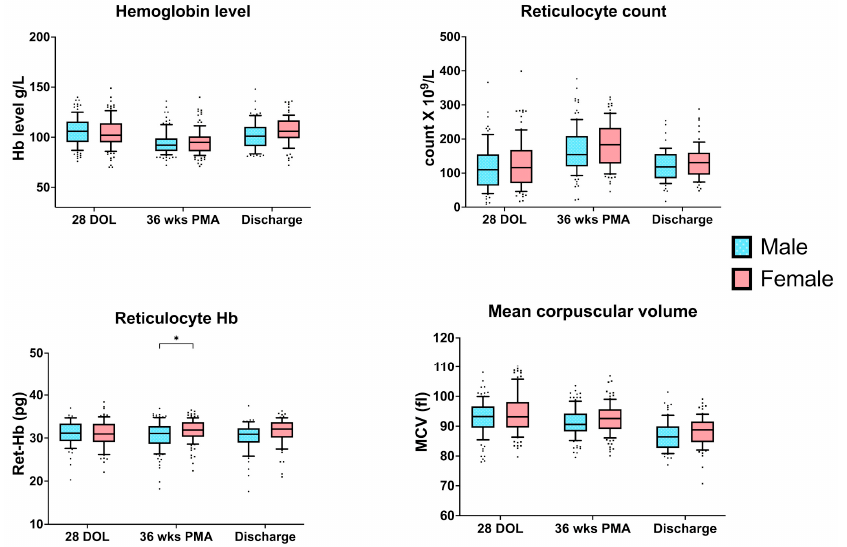
Figure 2. Sex differences in hematological parameters at three time points. Median (IQR) of each hematological variable specific to each sex is plotted. Unpaired Student’s t -test with False Discovery rate (FDR) approach for multiple comparison. * p value < 0.05. Although at all time points female infants tend to have higher values of hematological parameters compared to male infants, the mean difference in Ret-Hb levels at 36 weeks PMA reached statistical significance. Abbreviations: DOL, Days of Life; PMA, Postmenstrual Age; Hb, Hemoglobin; Ret-Hb, Reticulocyte Hemoglobin; MCV, Mean Corpuscular Volume.